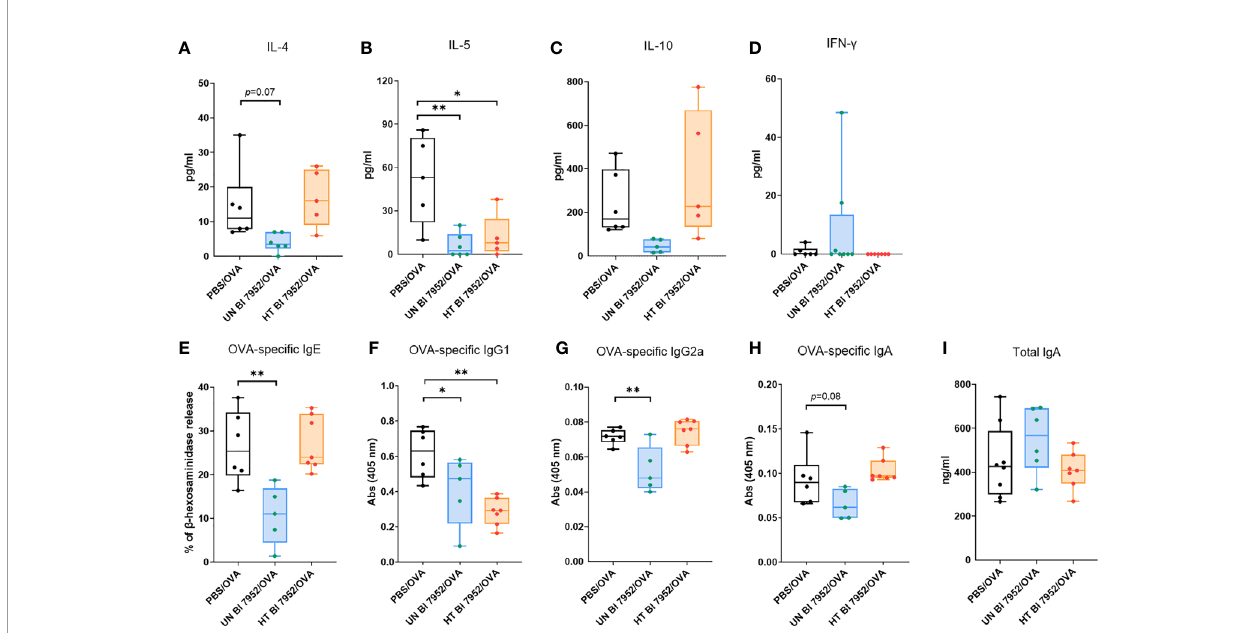
FIGURE 5 | Intranasal administration of untreated and heat-treated Bl 7952 differently attenuates the OVA-induced cellular and humoral immune responses. Effect of PBS (PBS/OVA, black box), untreated Bl 7952 (UN Bl 7952/OVA, blue box) and heat-treated Bl 7952 (HT Bl 7952/OVA, orange box) strain on cytokine production was determined in supernatants of OVA-stimulated splenocytes isolated from bacteria or PBS pre-treated and OVA-sensitized and challenged mice. (A) IL-4, (B) IL-5, (C) IL-10 and (D) IFN- g cytokines are expressed as pg/ml. Levels of OVA-speci fi c (E) IgE as % of b -hexosaminidase release by RBL assay, (F) IgG1, (G) IgG2a, (H) IgA and (I) total IgA antibodies were measured in sera of experimental mice. Values are expressed as boxplot with mean and min to max value bars; each dot represents a single mouse. Signi fi cant difference between PBS/OVA and bi fi dobacteria-treated/OVA experimental groups was calculated by one-way ANOVA with Dunnett ’ s multiple comparison test *p <.0.05. **p <